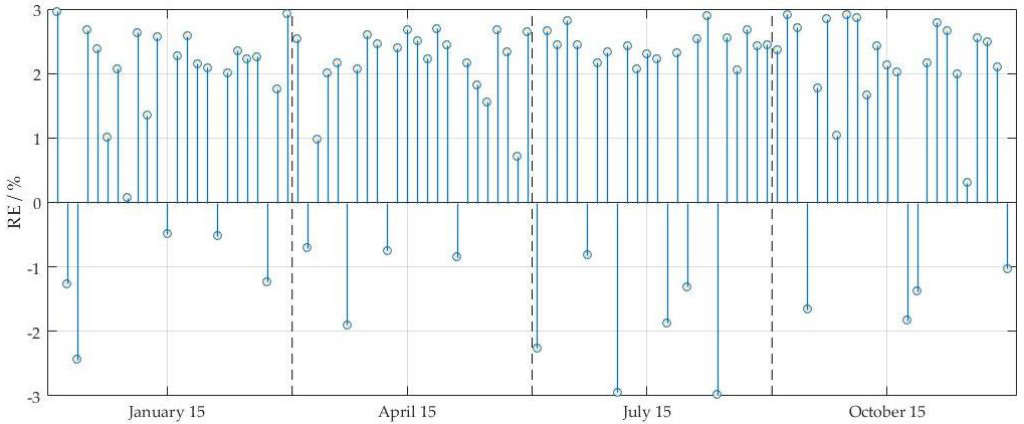
Figure 8. The RE of the proposed model.